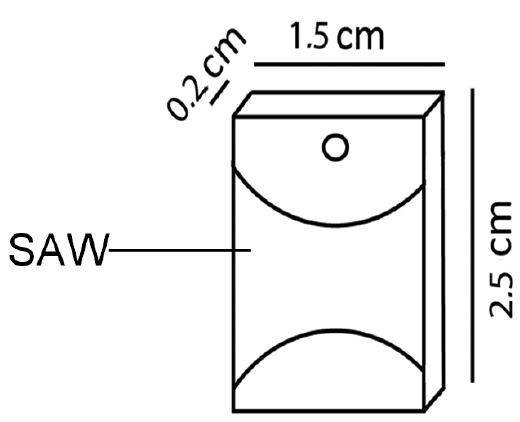
Figure 2. Dimensions of specimens of the SAW welded joint.